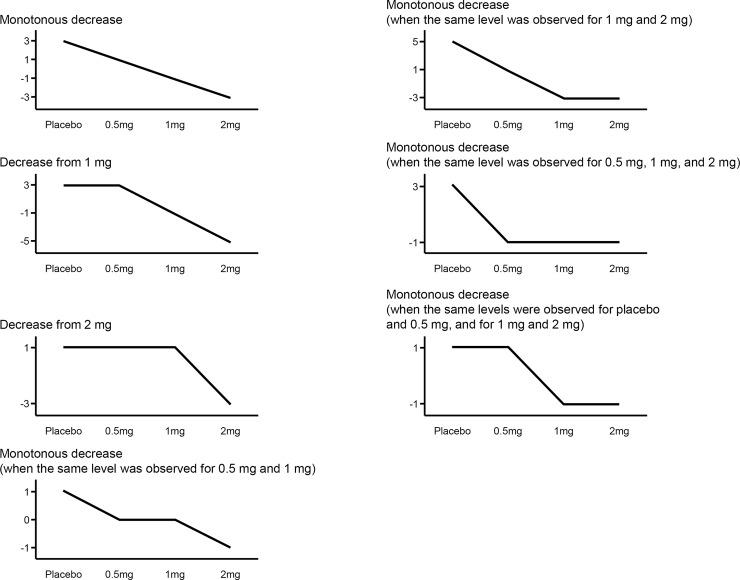
Contrast patterns used for the dose-response profile of evocalcet.The dose-response profile was examined using seven types of contrast patterns involving the respective mean values in the evocalcet 0.5, 1, and 2 mg and placebo groups. The contrast coefficients are displayed on the y-axis of each graph.